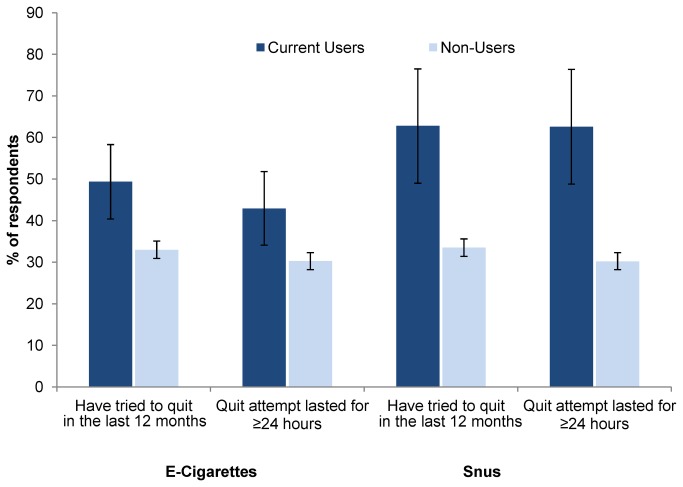
Quit attempts among current users of E-Cigarettes and Snus versus non-users.